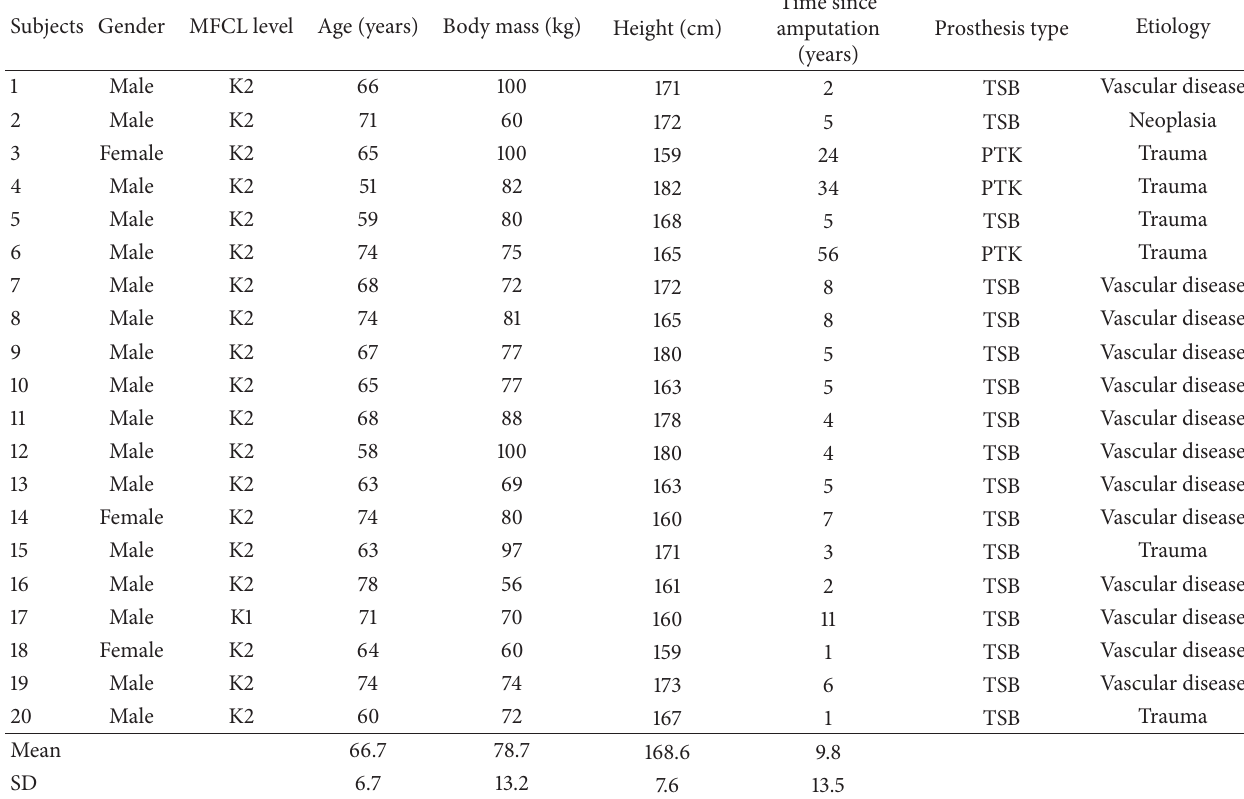
Table 1: Demographic features of study subjects with different Medical Functional Classification Level (MFCL) fitting two main prosthesis types: Total Surface Bearing (TSB) and Prosthesis Tibiale Kegel (PTK).